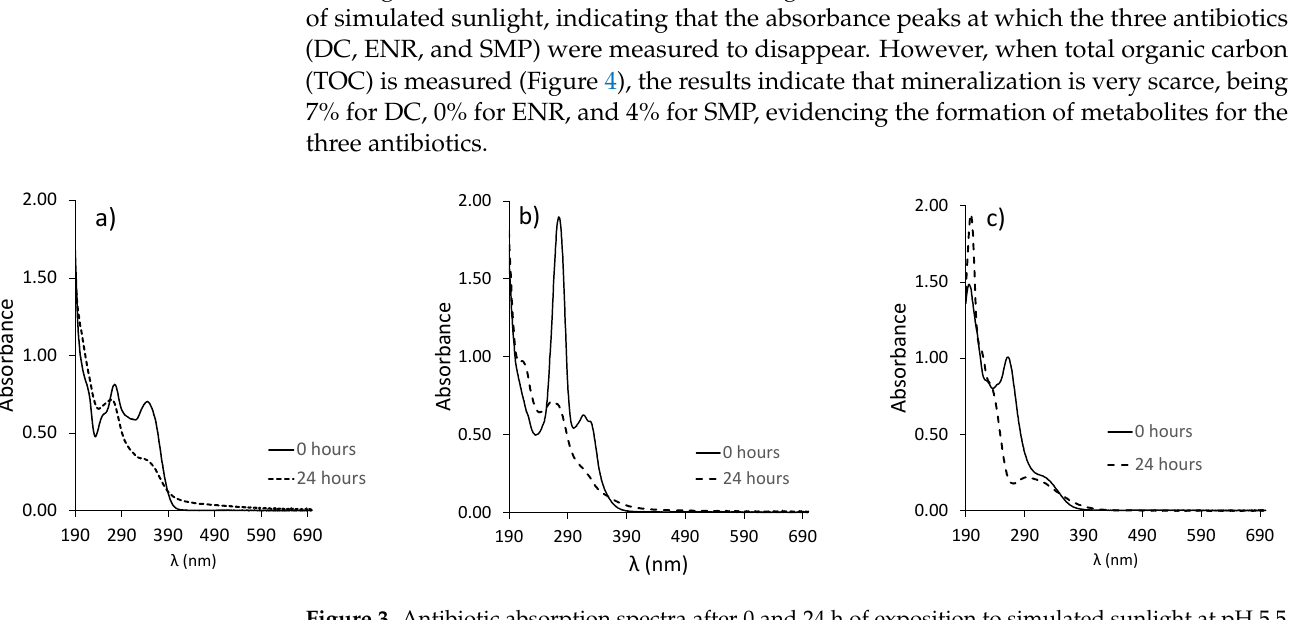
Figure 3. Antibiotic absorption spectra after 0 and 24 h of exposition to simulated sunlight at pH 5.5. ( a ) Doxycycline (DC); ( b ) Enrofloxacin (ENR); ( c ) Sulfamethoxypyridazine (SMP).